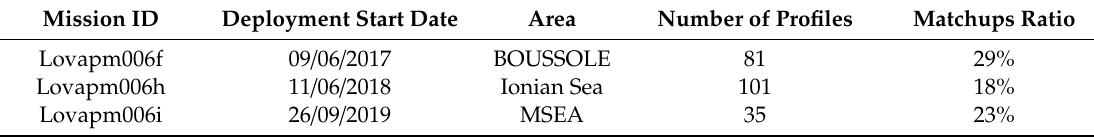
Table 9. Matchups ratio for three deployments in the Mediterranean Sea with S3